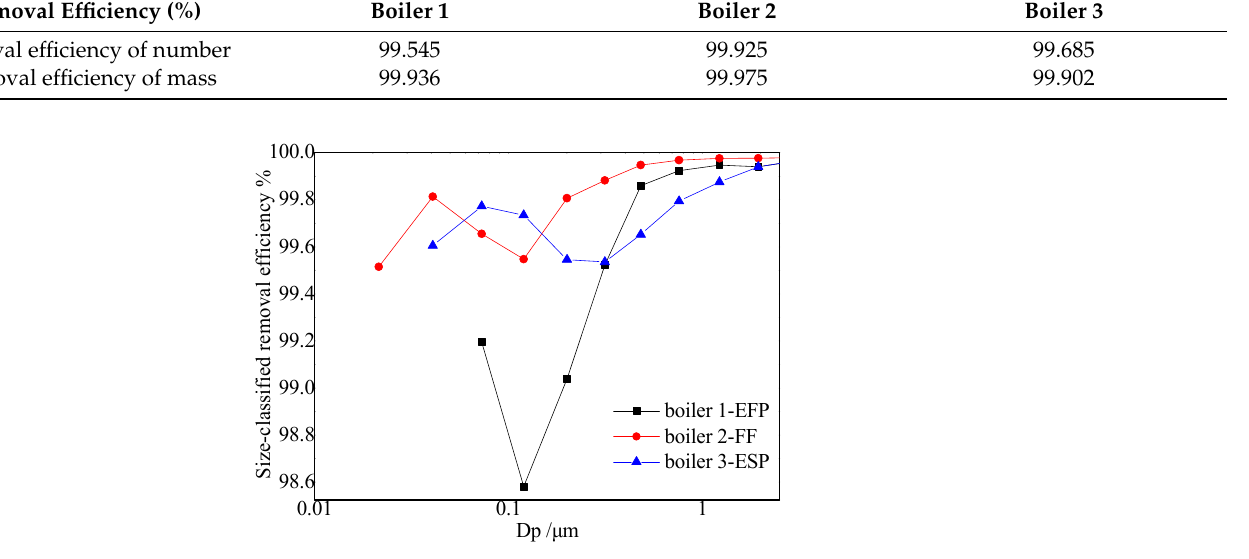
Figure 4. Size-classified removal efficiency of fine particle emitted by CFB boiler through different dust removal devices.